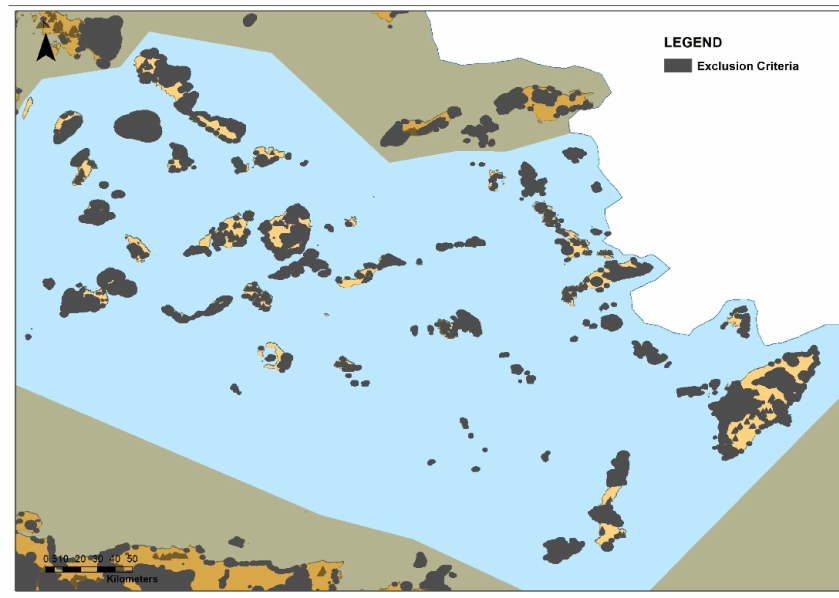
Figure 4. Inappropriate areas for the siting of wind farms on UIs in the region of the South Aegean, Greece. Table 3. Characteristics of eligible UIs for the siting of wind farms in the region of the South Aegean, Greece.